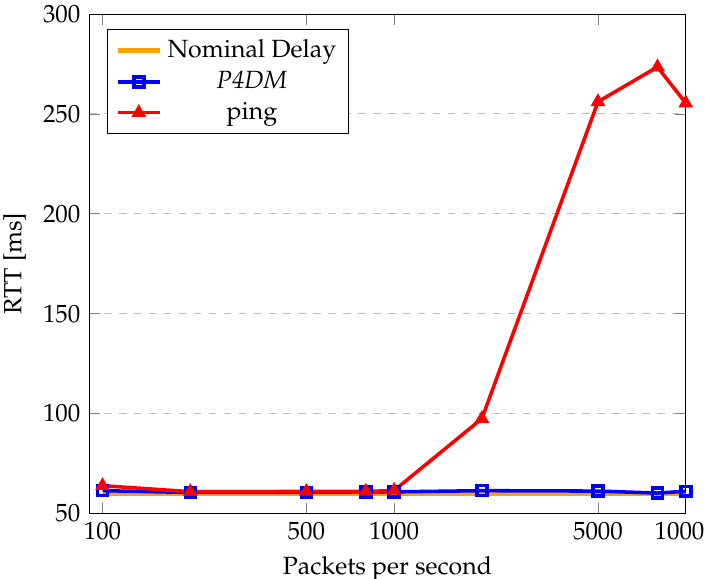
Figure 8. P4DM and ping RTT